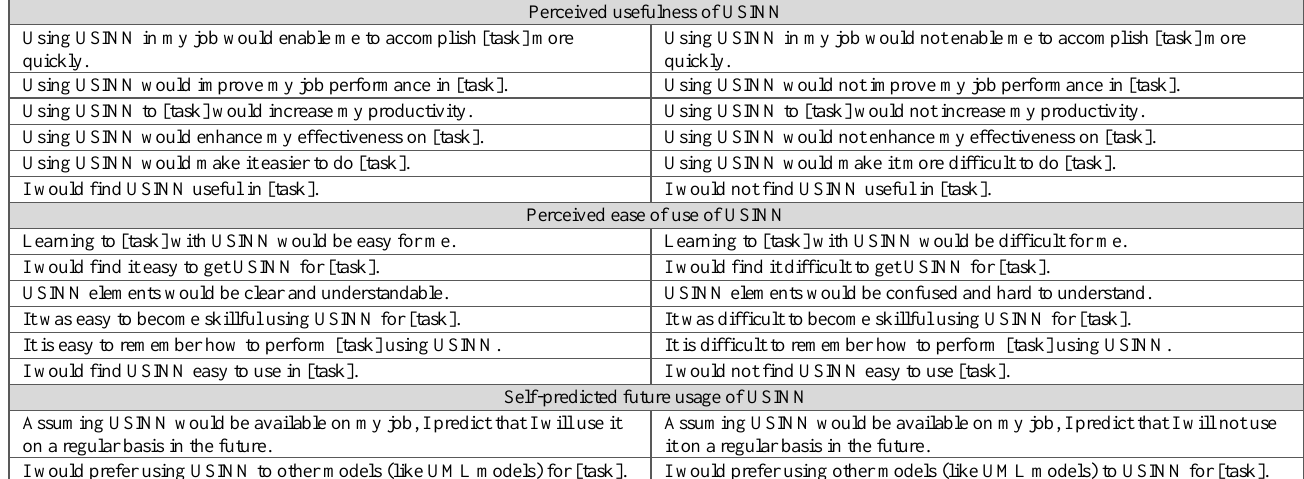
TABLE VI. Q UESTIONS OF SUBJECTIVE METRICS QUESTIONNAIRE